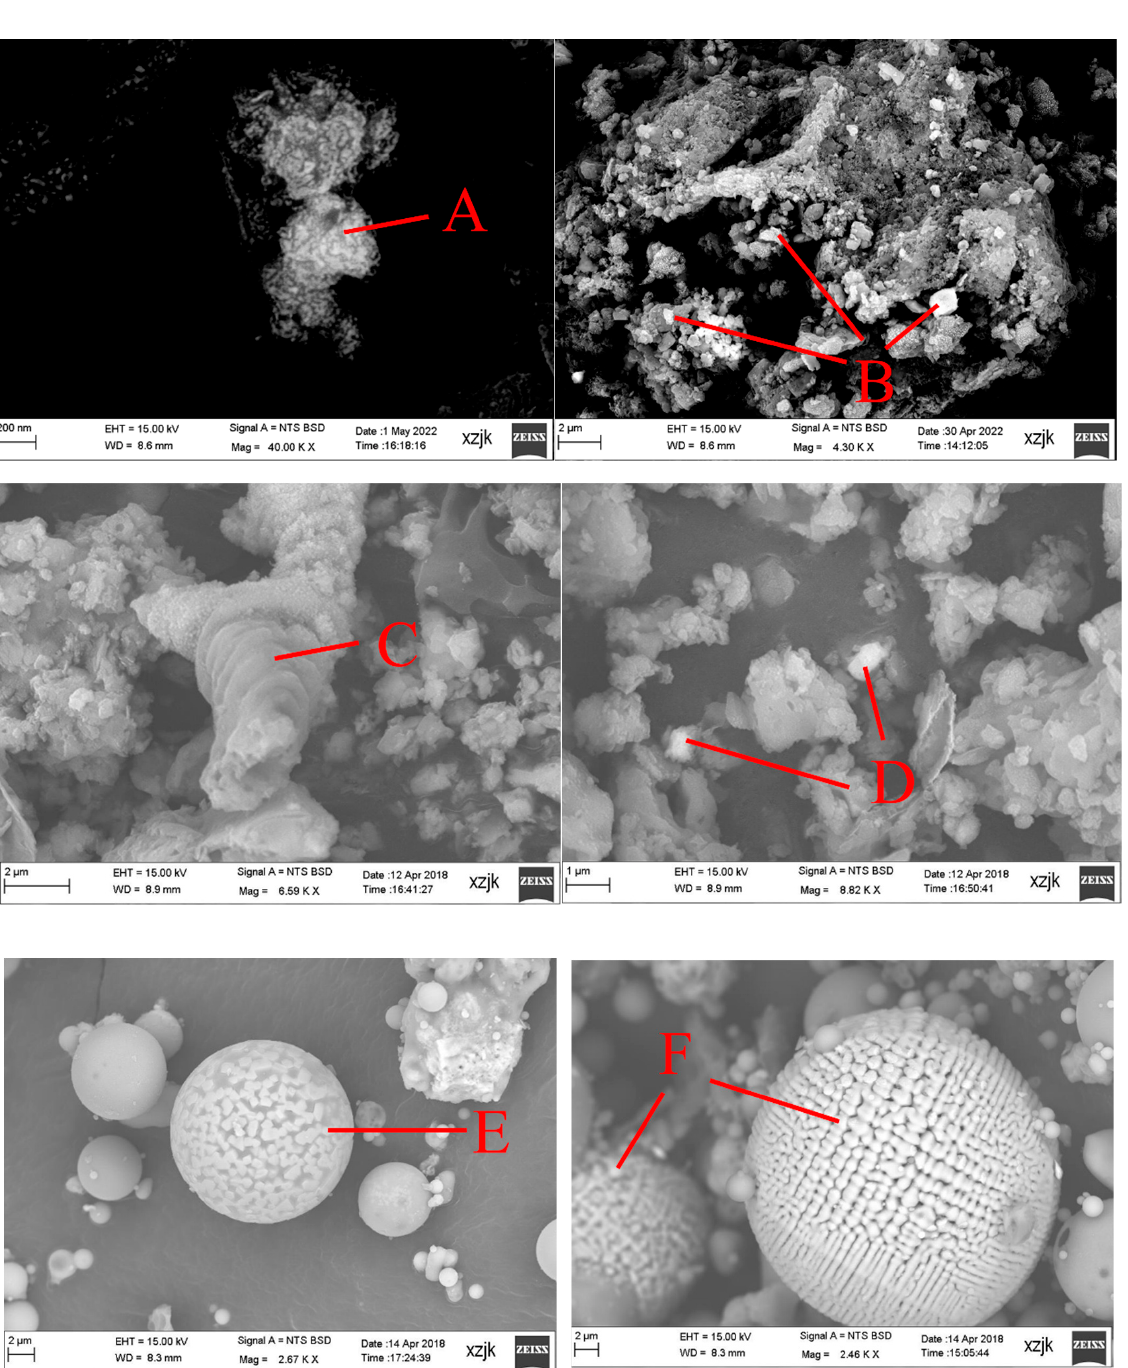
8 of 16 Figure 4. The contents and distribution of iron and REY in three coal ash samples. The magnetic fraction in CA1 and CA2 and Mag-1 fraction in CA3 were observed by SEM-EDS, as shown in Figure 5 and Table 3. Point A is a typical hematite particle bond to the aluminosilicate phase. Point B indicated that the micro- or nano-particles of iron dis- tribute on or surrounding the aluminosilicate phase. Point C is the heated kaolinite sur- rounding/reacting with other elements phase based on the stratified structure and ele- mental analysis. Point B is a magnetic particle coupled with the aluminosilicate phase. As the product of the CFB furnace, other areas except for points C and D represent the typical characteristic that the particles are irregular, fragmental, and agglomerated into large par- ticles [36,37]. That is the reason why some particles were entrained into the magnetic frac-